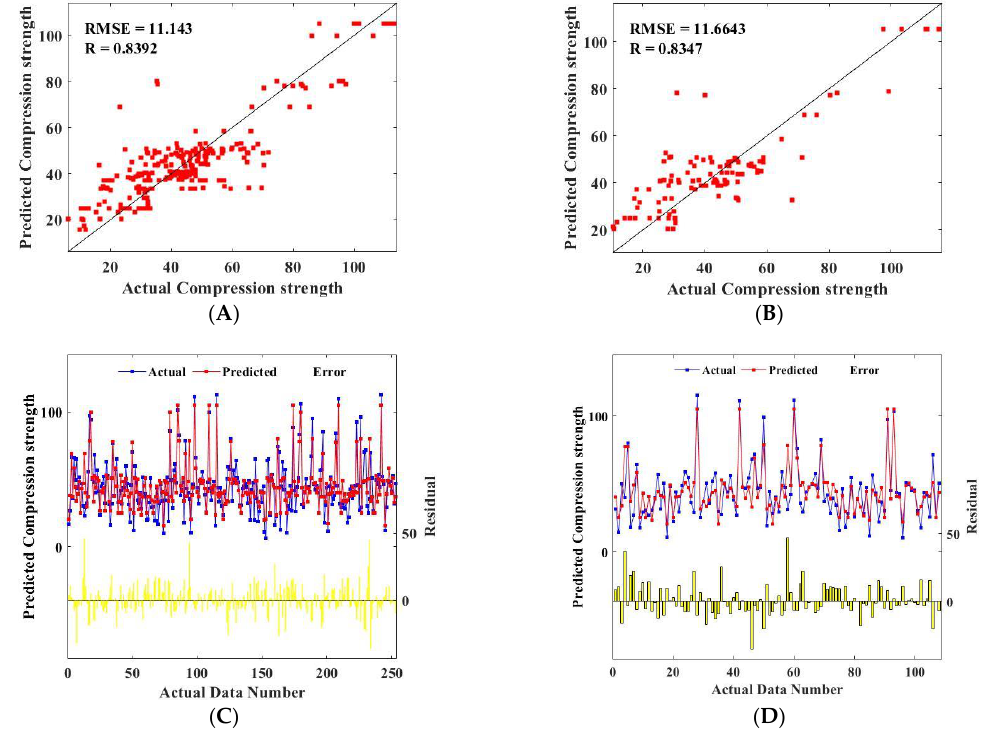
Figure 4. Comparison of the actual compressive strength and predicted compressive strength (RF model): (A) predicted results of the training set; (B) predicted results of the testing set; (C) comparison results of the training set; (D) comparison results of the testing set.